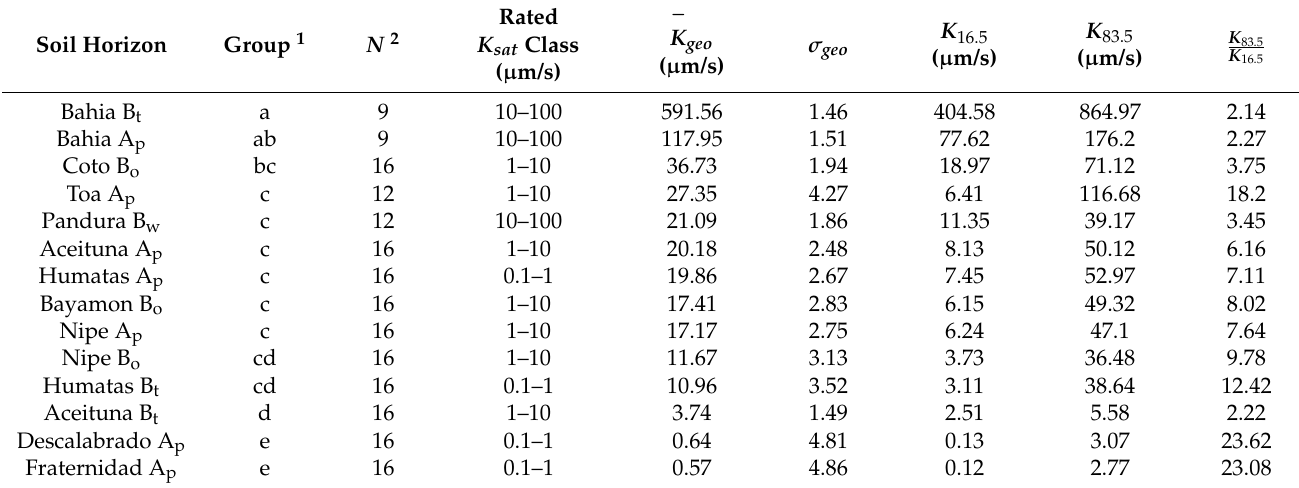
Table 5. Statistical data for K sat values measured in different soil